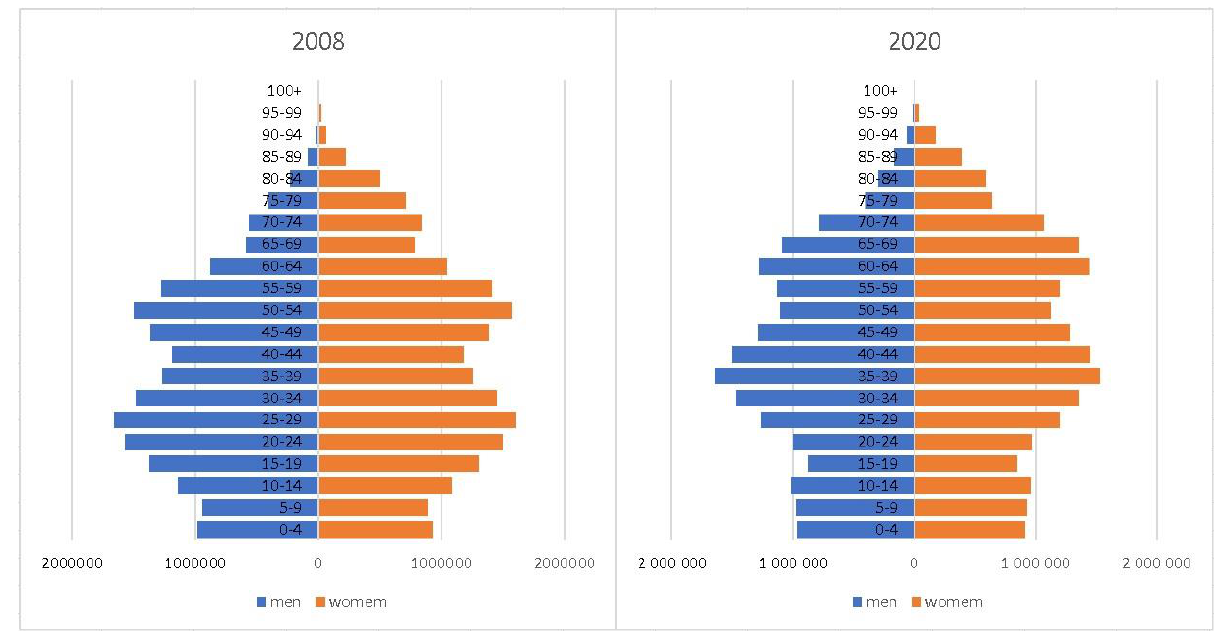
Fig. 2. The gender and age pyramid of Poland in 2008 and 2020 (Source: Own elaboration) Table 1. Demographic changes in Poland and in the selected voivodships in 2008 and 2020 (Source: Own elaboration) Pre-working Voivodeships/Poland Year